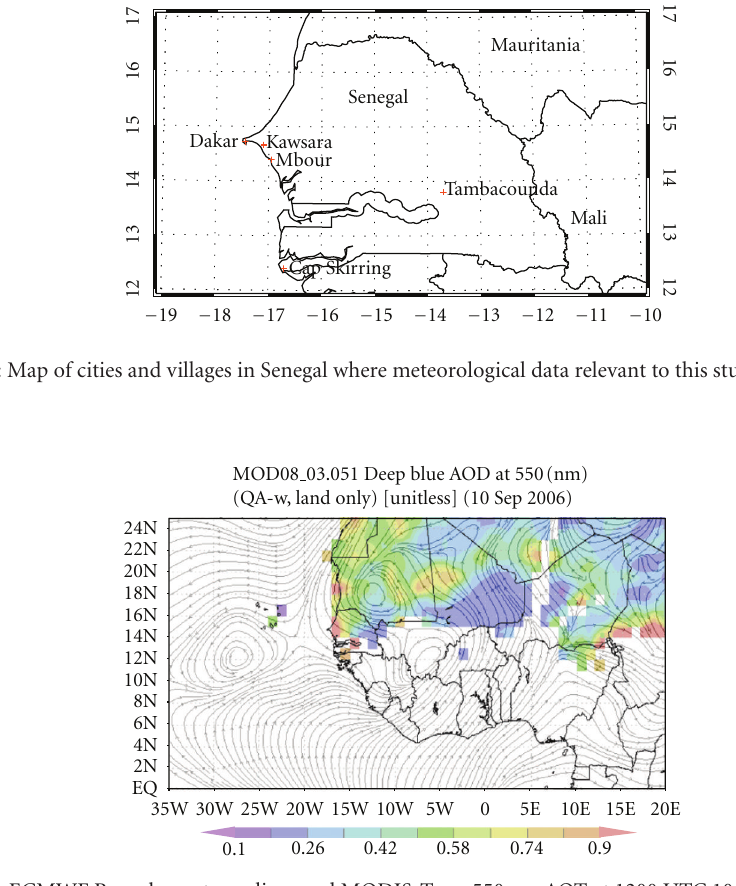
Figure 2: ECMWF Reanalyses streamlines and MODIS-Terra 550nm AOT at 1200 UTC 10 September